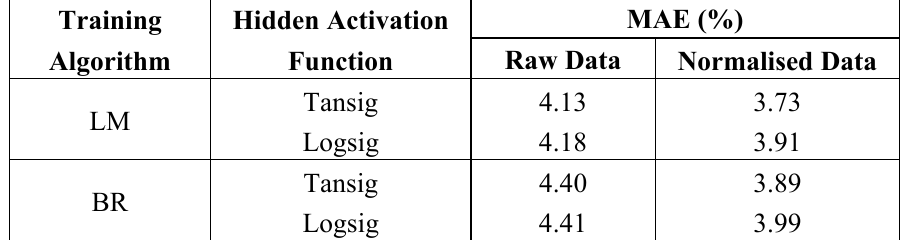
Table 2. The MAE values for MLP oil fraction sensors trained using different training algorithms and hidden activation